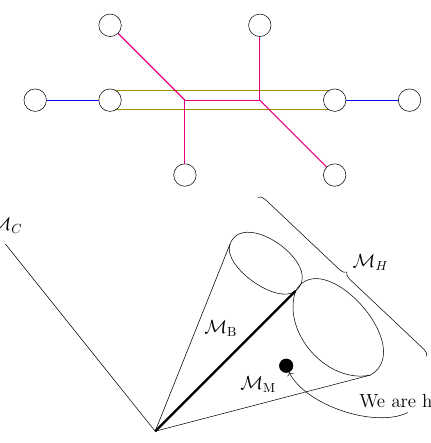
(b) The mesonic branch is indicated in the brane web. Coloured branes are assumed to be on different ( x 7 , x 8 , x 9 ) positions in space.